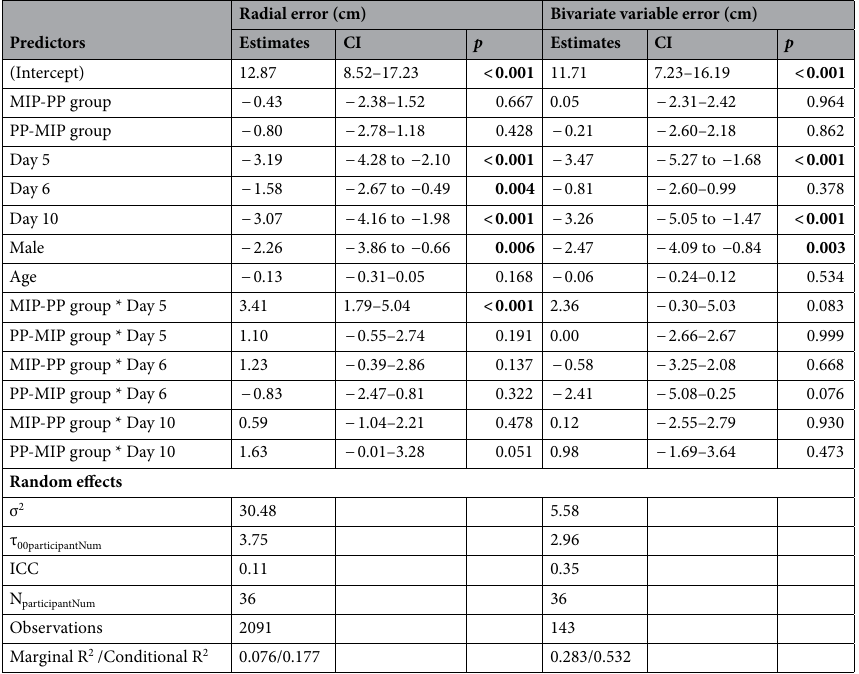
Table 2. Linear mixed effects conducted to assess changes related to radial error and bivariate variable